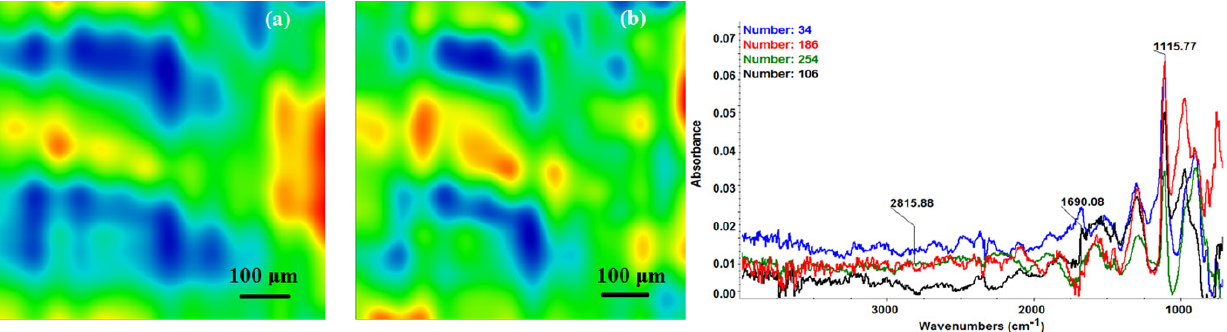
Figure 3. Second derivate IR mappings and IR spectra of thin coating (F = 300 mJ/cm 2 ) surface: intensity distribution of ( a ) 2815 cm